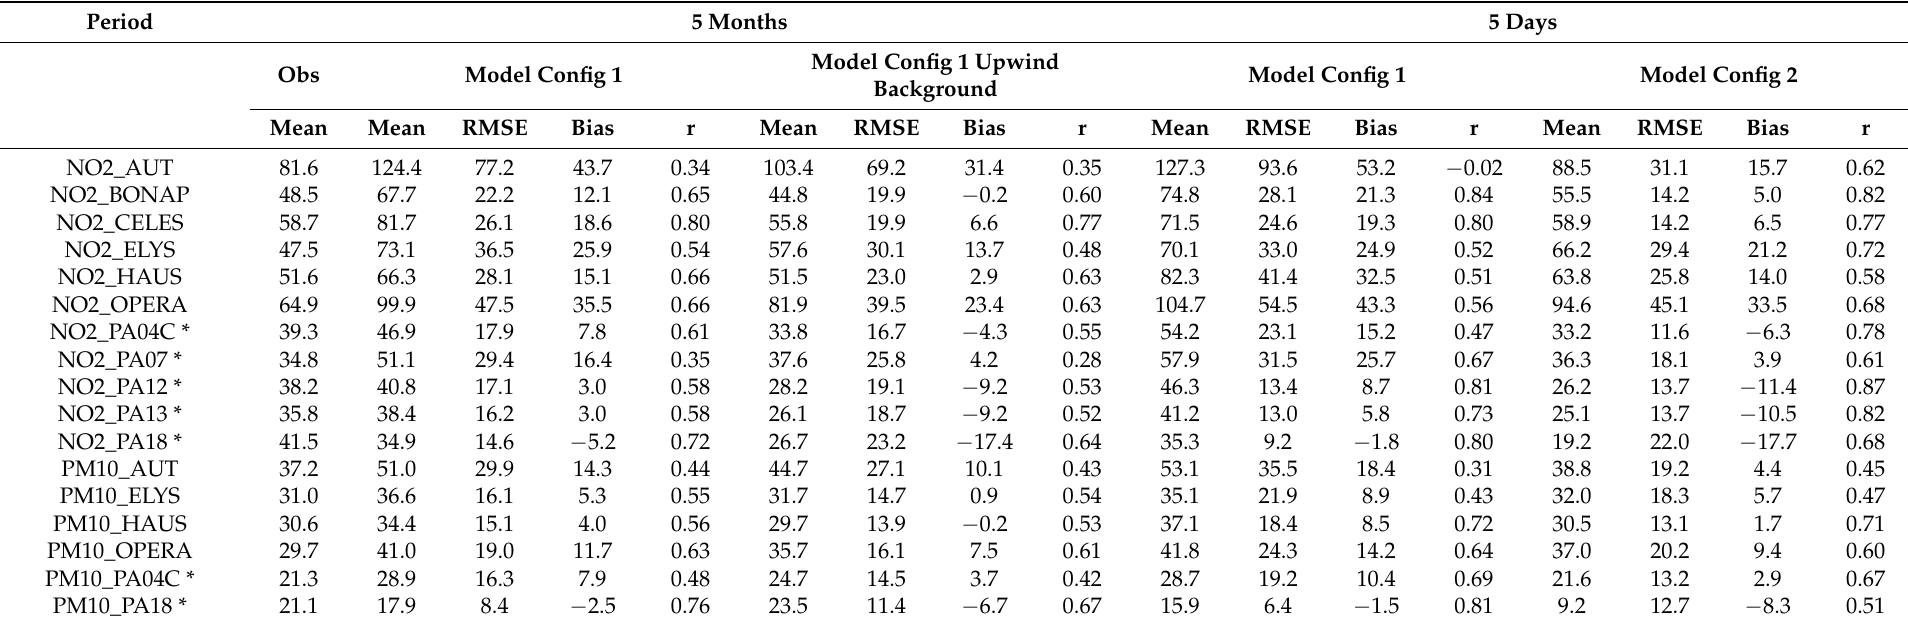
Table 5. Comparative statistics between observed and computed hourly average concentration of NO 2 and PM10 in µ g · m − 3 —Config 1 corresponds to the initial parametrization of PMSS and background concentration extracted on Paris cell in the regional modelling; Config 1 Upwind background corresponds to the same parametrization of PMSS, but with background concentration extracted upwind Paris cell in the regional modelling; Config 2 corresponds to the parametrization of PMSS with a correction on the stability coefficient, and with background concentration extracted from the upwind Paris cell in the regional modelling; 5 months and 5 days corresponds, respectively, to the large period modelled initially, and to the sub list of 5 days used